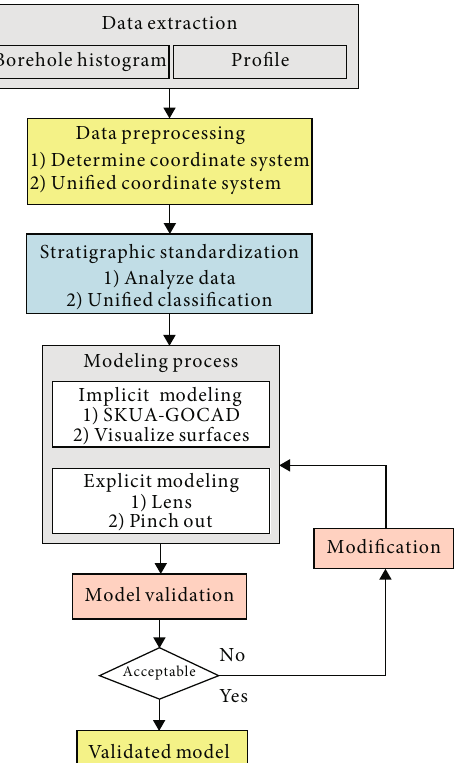
Figure 2: The urban 3D geological modeling process based on borehole data.